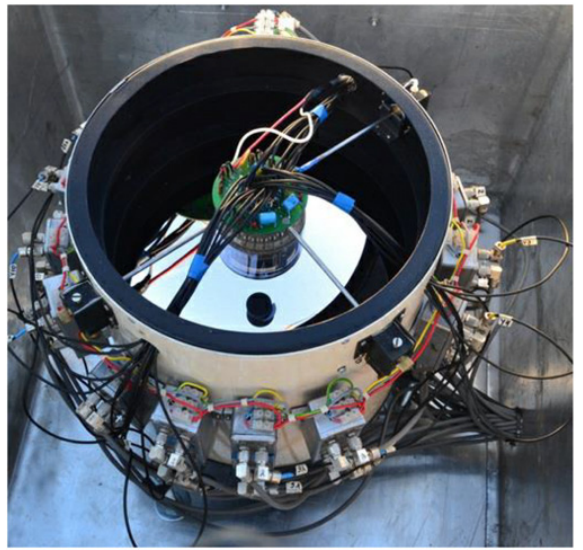
Figure 1. Wide field of view Cherenkov telescope prototype.